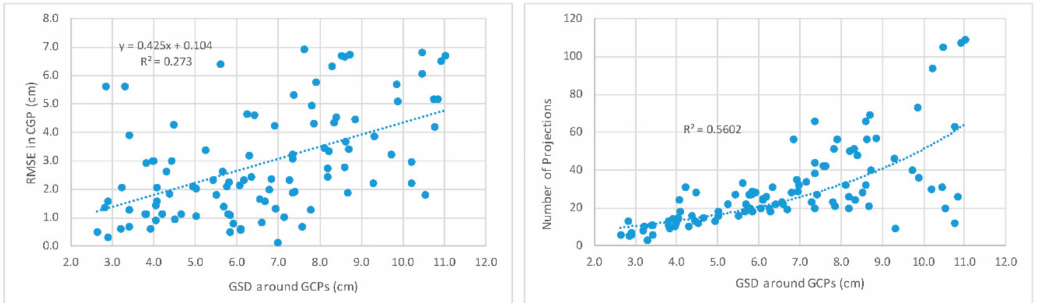
Figure 8. Accuracy analysis as a function of the ground sample distance (GSD) at the ground points ( left ) and number of image projections as a function of the GSD at the ground points ( right ). The obtained fit is specific to this case